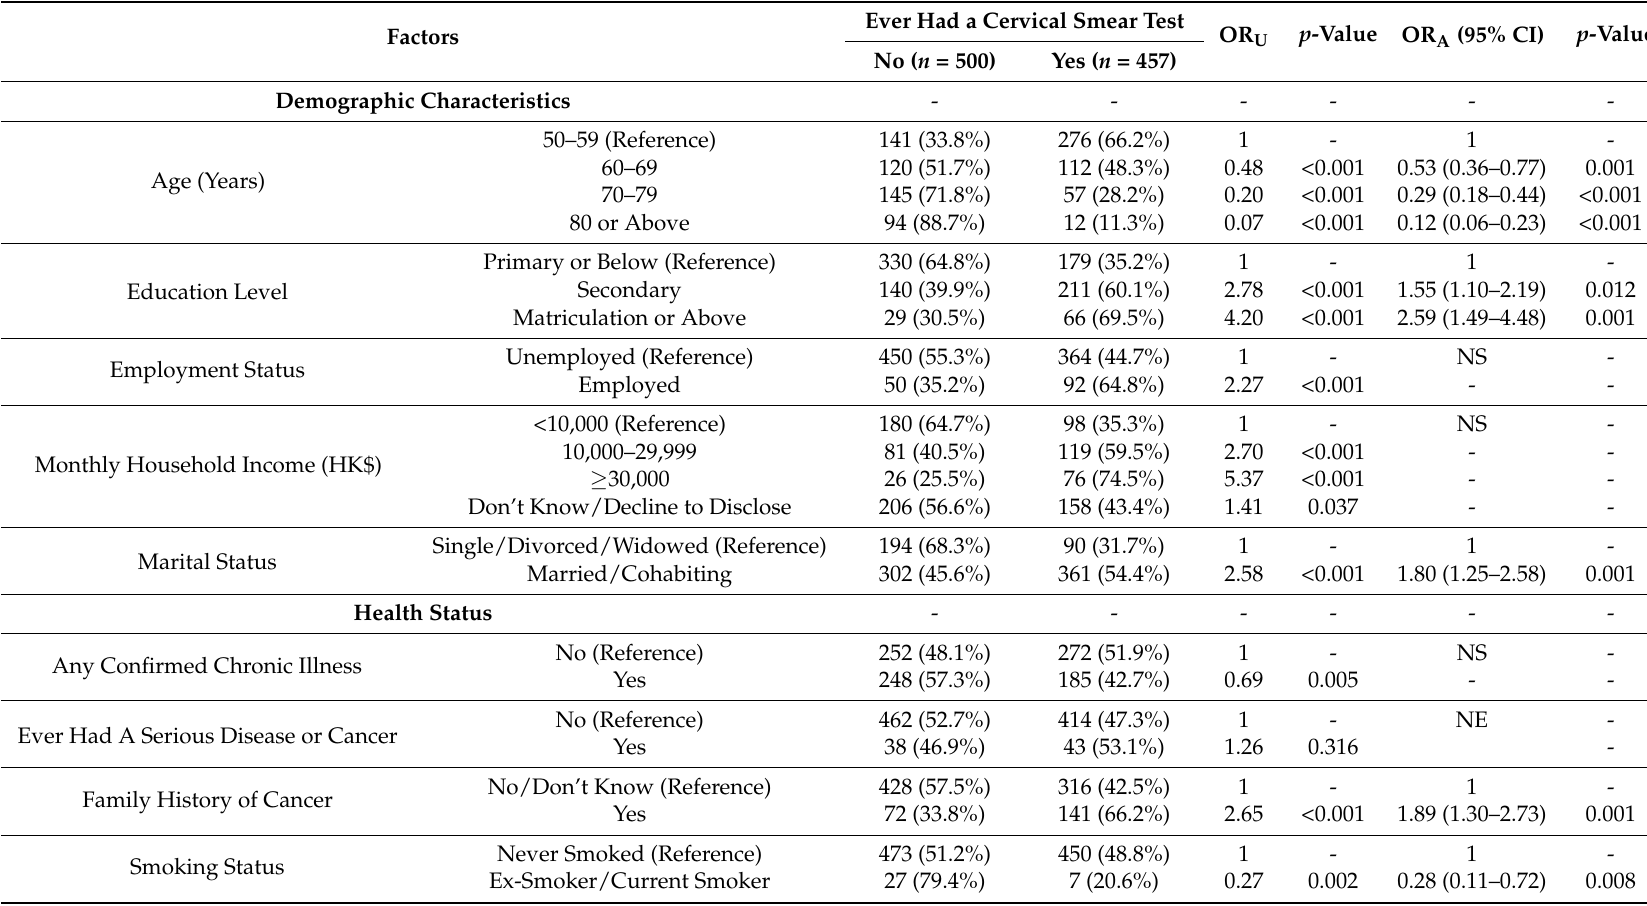
Table 4. Factors associated with ever having had a cervical smear